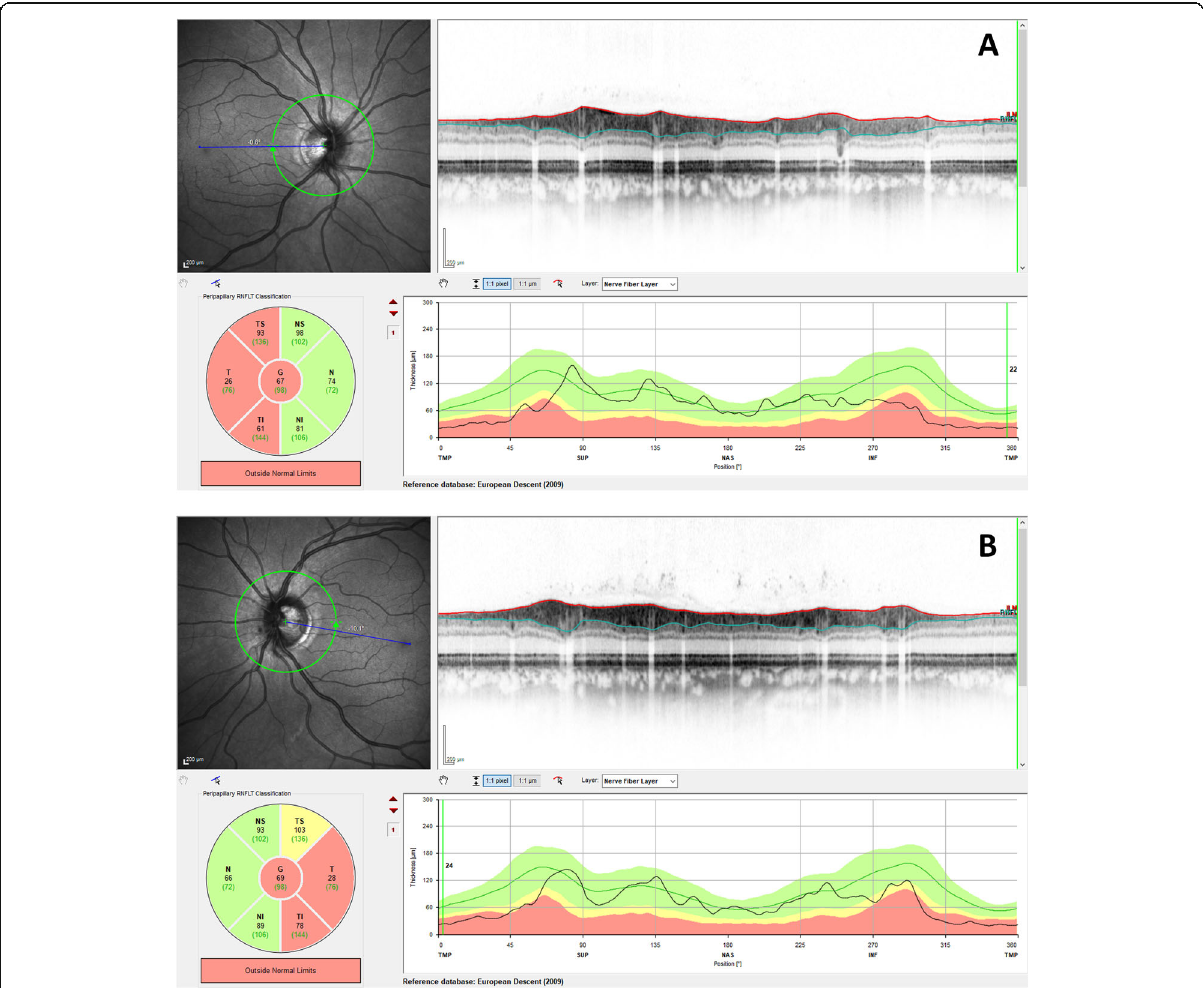
Fig. 2 Optical coherence tomography (OCT) of the retinal nerve fiber layers (RNFLs). The right eye ( a ) and left eye ( b ) OCT of the affected proband show temporal thinning of